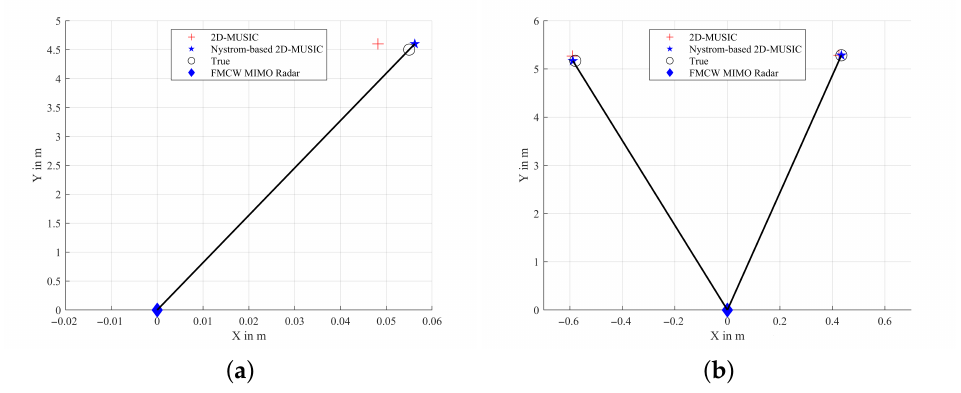
Figure 12. A comparison of target localization Results: ( a ) Single target. ( b ) Two Targets.